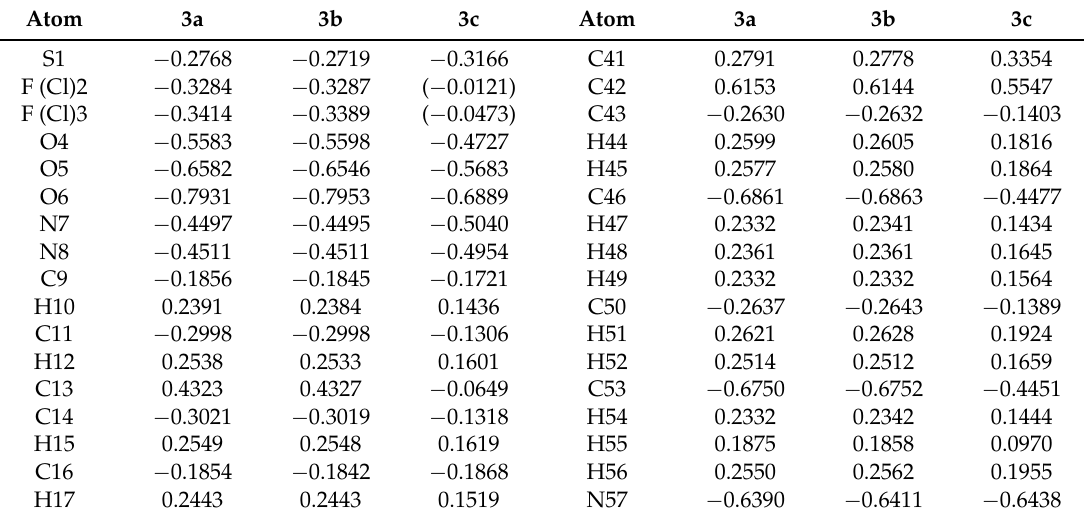
Table 5. The B3LYP/6-31G(d) calculated natural